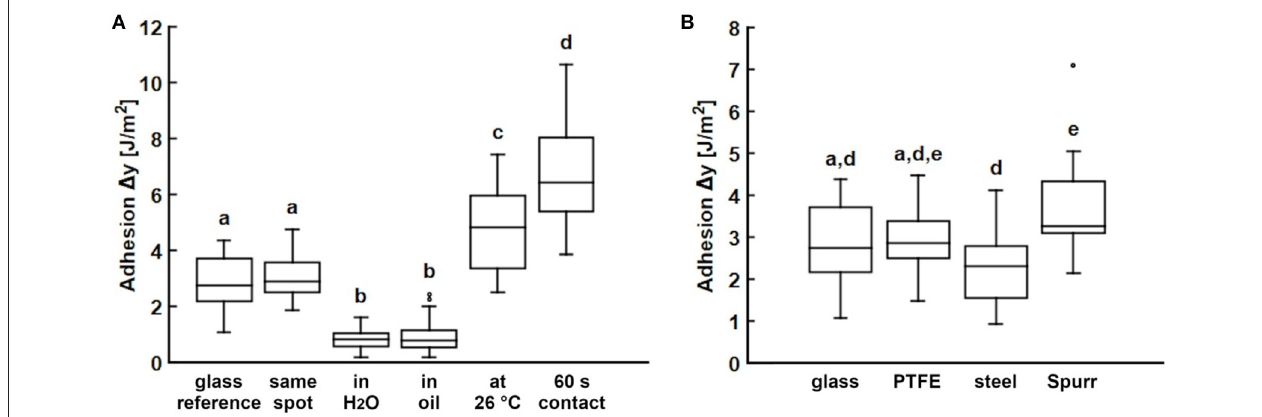
FIGURE 5 | Propolis adhesion. (A) Adhesion of propolis on glass under various conditions. (B) Adhesion of propolis on different substrates. Experiments were conducted using Basalt-1 mechanical tester (Tetra GmbH, Ilmenau, Germany). If not stated differently, tests were carried out at room temperature (24 ◦ C) with a set loading force of 5 mN and with every individual measurement performed on a different location on the substrate ( N n 10 individual measurements per sample). Box plots show the median value (line), the ends of the boxes define the 25 and 75th percentiles, and the error bars the = 10 and 90th percentiles. The outliers are shown as black dots. Conditions and substrates marked with different letters differ significantly from each other (one-way ANOVA, P < 0.001 and Tukey test, P < 0.05).